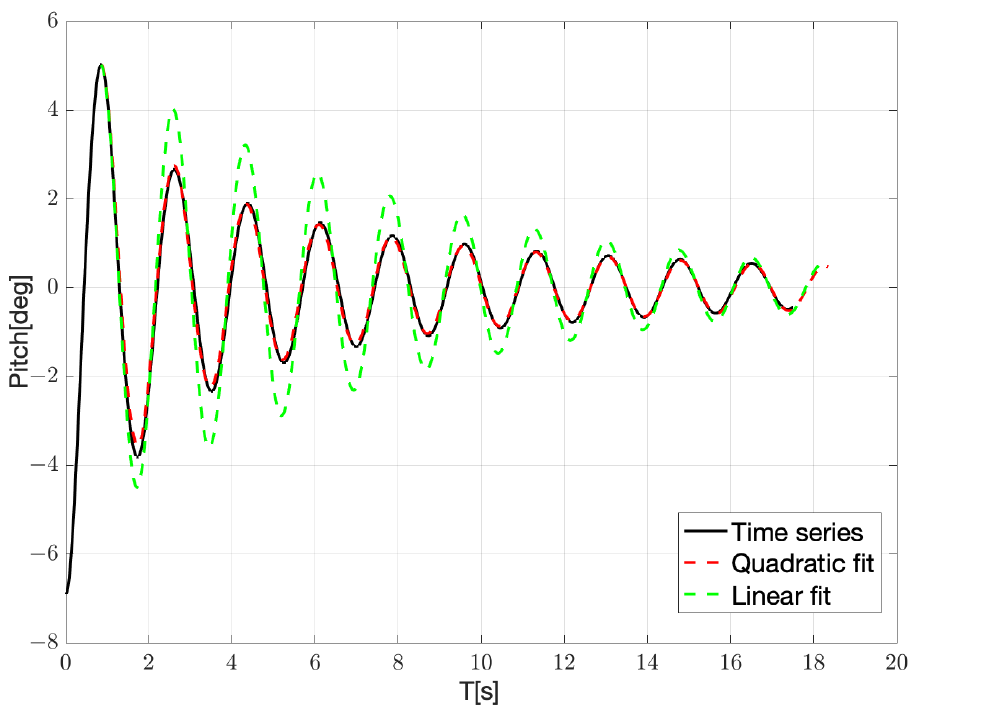
Figure 16. Time series and fit curves of the free decay test of pitch obtained from CFD simulation with Comb.1.